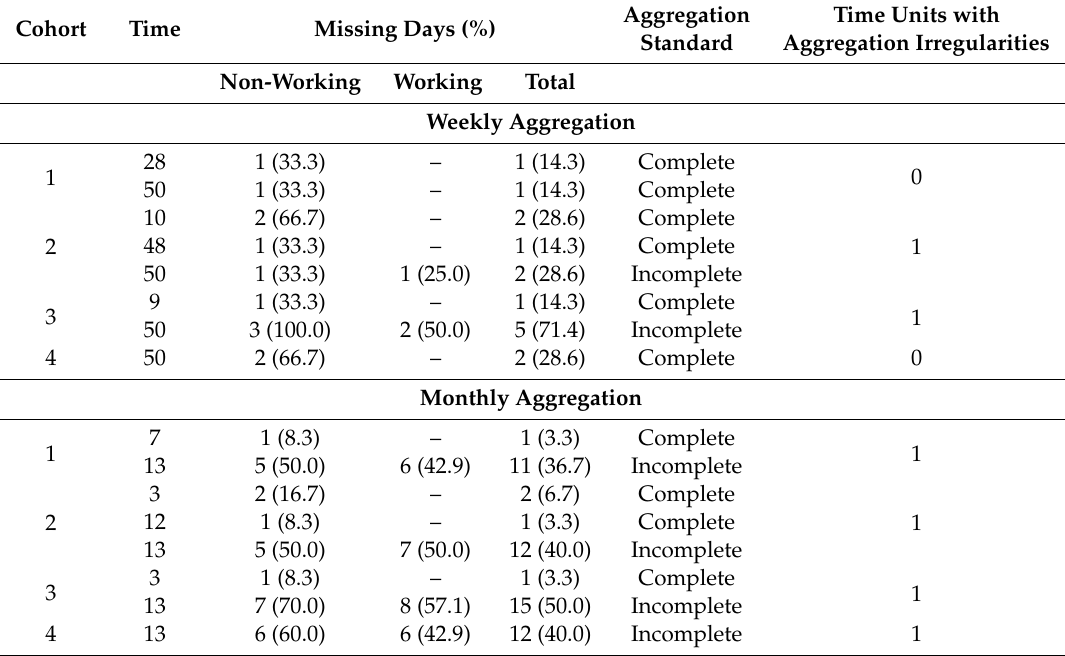
Table 3. Weeks and months with aggregation irregularities for the time series.